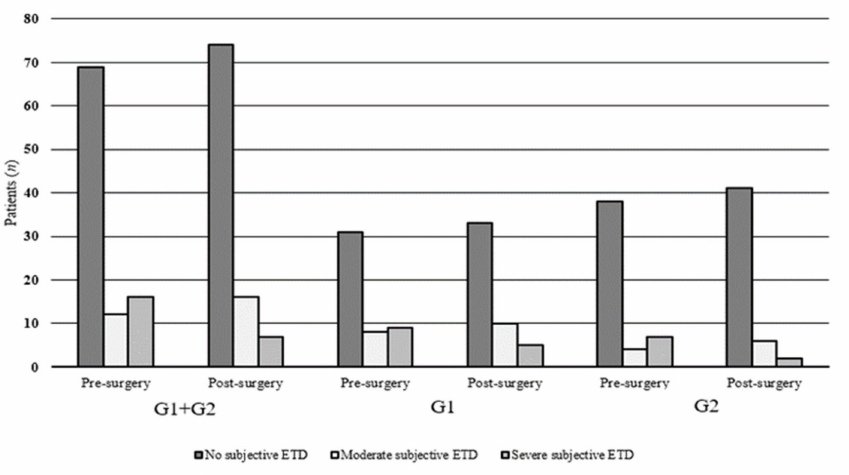
Figure 1. Eustachian Tube Dysfunction Questionnaire-7 (ETDQ-7) among atopic and non-atopic